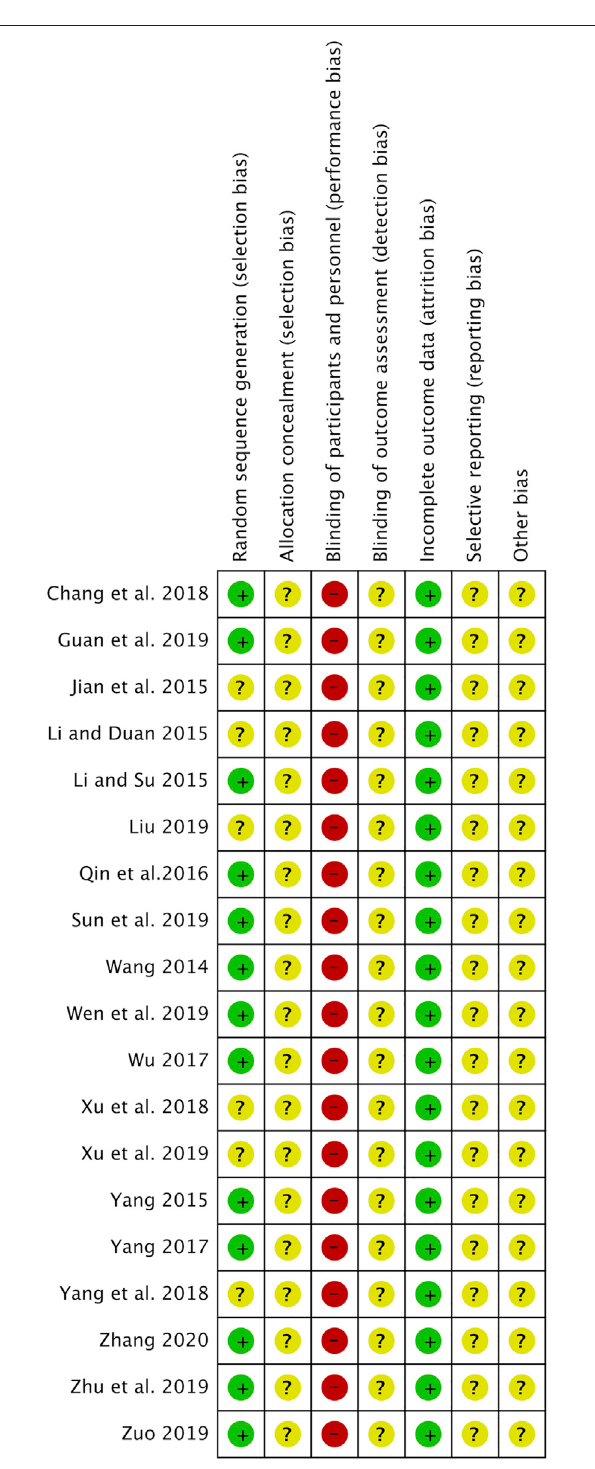
FIGURE 2 | Risk of bias (RoB)